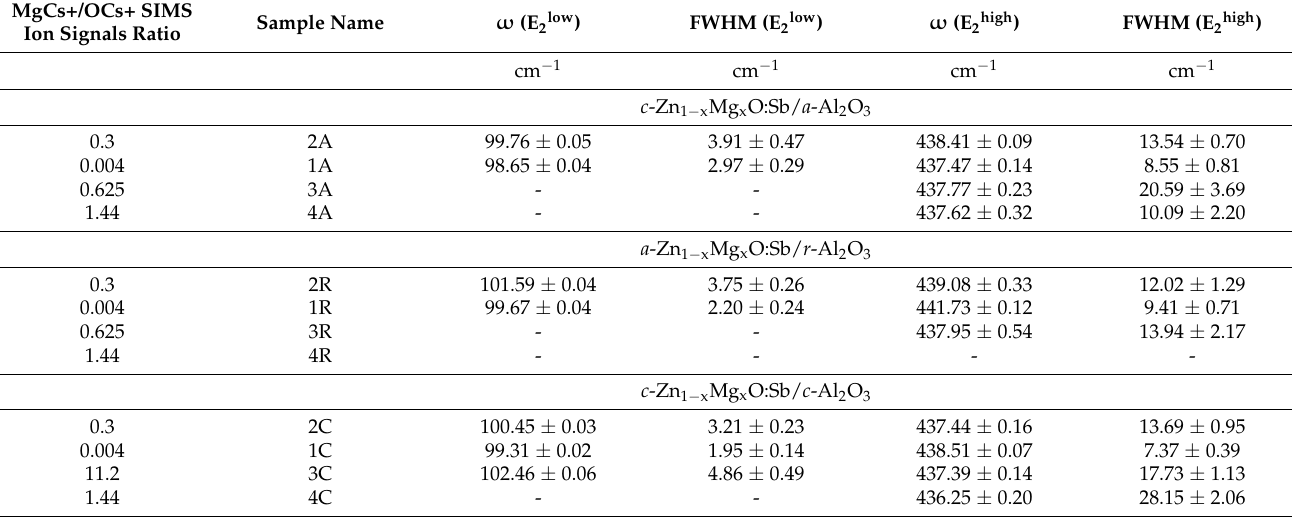
Summary of data for c -Zn 1 − x Mg x O:Sb/ a -Al 2 O 3 , a -Zn 1 − x Mg x O:Sb/ r -Al 2 O 3, and c